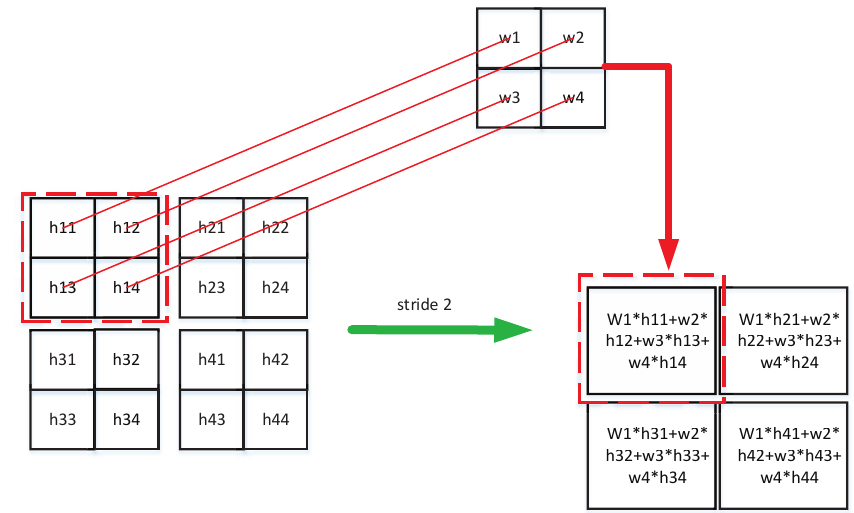
Figure 4. The basic operation of convolution layers. A new feature representation can be obtained by a